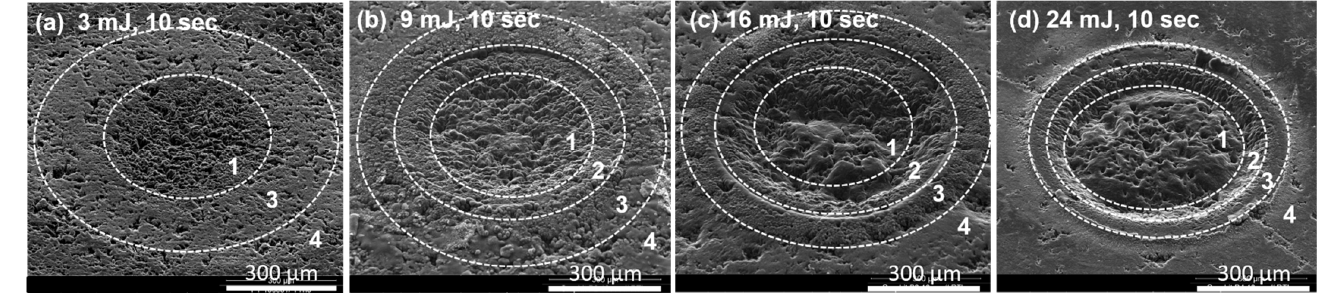
Figure 3. SEM images of graphite surfaces generated by different laser energies: ( a ) 3 mJ, ( b ) 9 mJ, ( c ) 16 mJ and ( d ) 24 mJ. Different zones 1–4 are indicated. The surface was tilted by 45°. Irradiation time: 10 s/150 pulses.